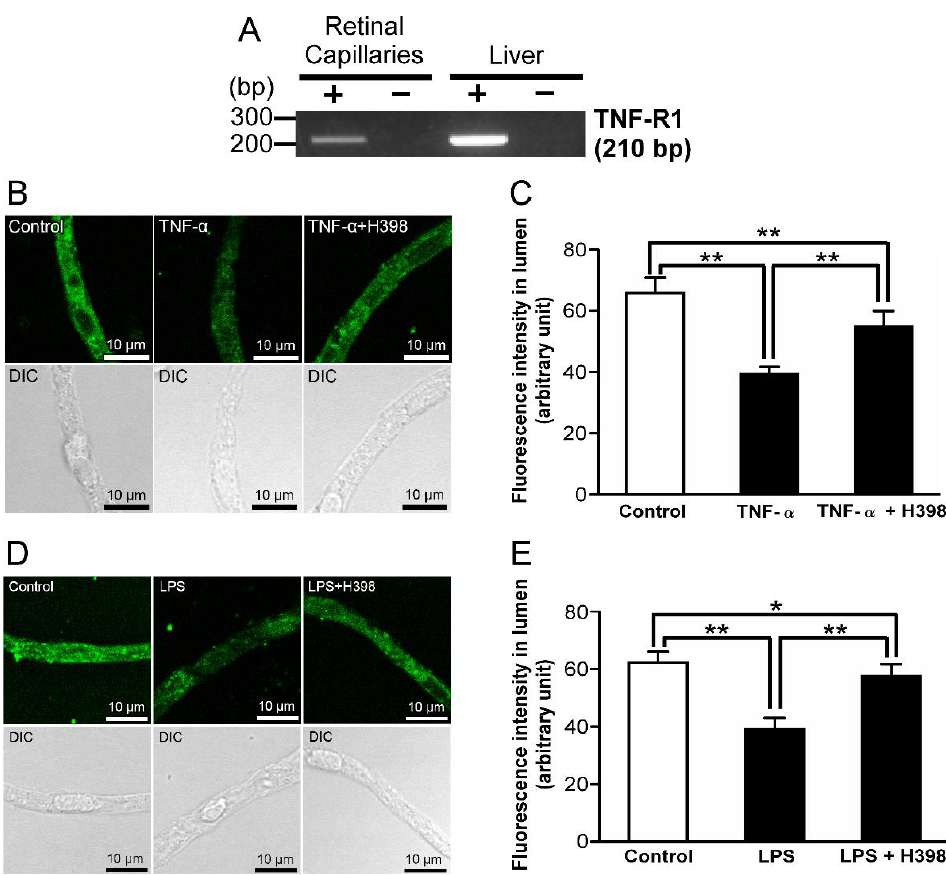
Figure 4. Effect of an inhibitor of TNF-receptor 1 (TNF-R1) on LPS-induced attenuation of P-gp- mediated transport activities in the retinal capillaries. ( A ) mRNA expression of TNF-R1 in rat retinal capillaries. RT-PCR analysis was performed in the presence (+) or absence ( − ) of reverse transcriptase using specific primers for TNF-R1. The rat liver was used as the positive control. ( B , D ) Representative confocal images of isolated rat retinal capillaries after incubation with 4 µ M NBD-CSA for 60 min. Capillaries were preincubated with 1 ng/mL TNF- α or 1 ng/mL LPS in the absence or presence of H398 (TNF-R1 antagonist) at 10 µ g/mL for 30 min. ( C , E ) Quantification of NBD-CSA fluorescence in the lumens of retinal capillaries. Each column represents the mean value for 10 capillaries from a single preparation; variability is given by S.D. bars. Units are expressed as arbitrary fluorescence (scale 0–255). * p < 0.05, ** p < 0.01, significantly different between the groups. Capillary images